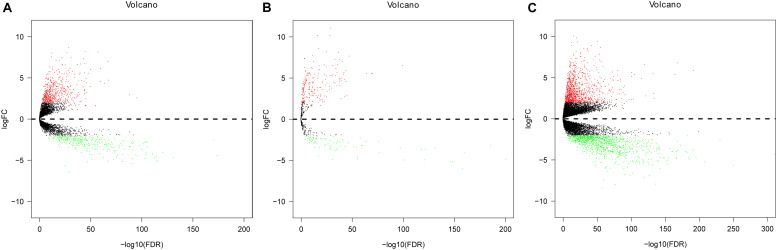
Volcano plot of differentially expressed lncRNAs (DElncRNAs), differentially expressed miRNAs (DEmiRNAs), and differentially expressed mRNAs (DEmRNAs) in colorectal cancer (CRC) and non-tumorous adjacent-normal samples. (A) Volcano plot of differentially expressed lncRNAs (DElncRNAs). (B) Volcano plot of differentially expressed miRNAs (DEmiRNAs). (C) Volcano plot of differentially expressed mRNAs (DEmRNAs). Log2fold change (log2FC) > 2 was labeled in red; log2FC < -2 was in green (P < 0.01).